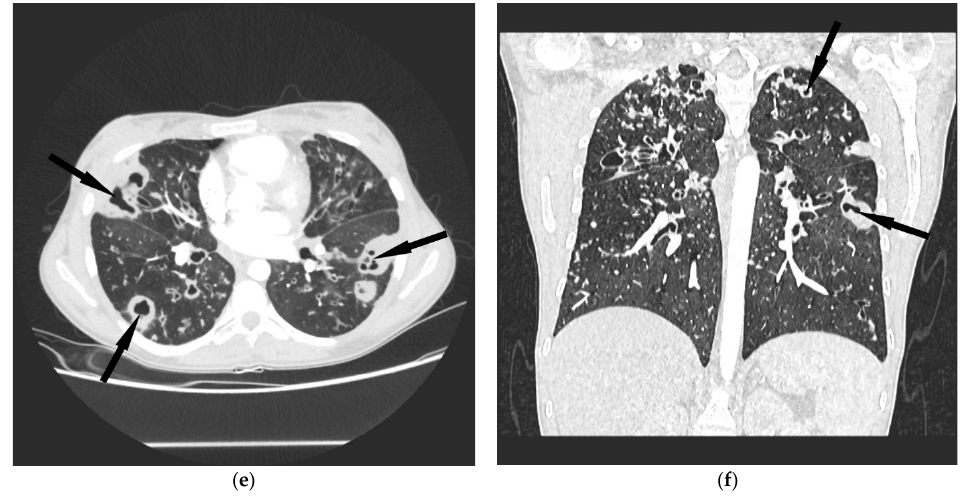
Figure 1. 26-years old female with cystic fibrosis and NTMLD (cavitary form). Evolution of chest CT changes from 2018 ( a – c ) to 2020 ( d – f ). ( a – c ) Chest CT scans (lung window, axial and coronal view) demonstrating bronchiectasis of the large and smaller airways (black arrows), centrilobular nodules (white arrows) and bronchial wall thickening predominating in the upper lobes. ( d – f ) Chest CT images (lung window, axial and coronal view) demonstrate progression of changes—bronchiectasis has worsened, inflammatory changes became larger, thick wall cavities have appeared (black arrows) which can indicate pulmonary infection caused by NTM.